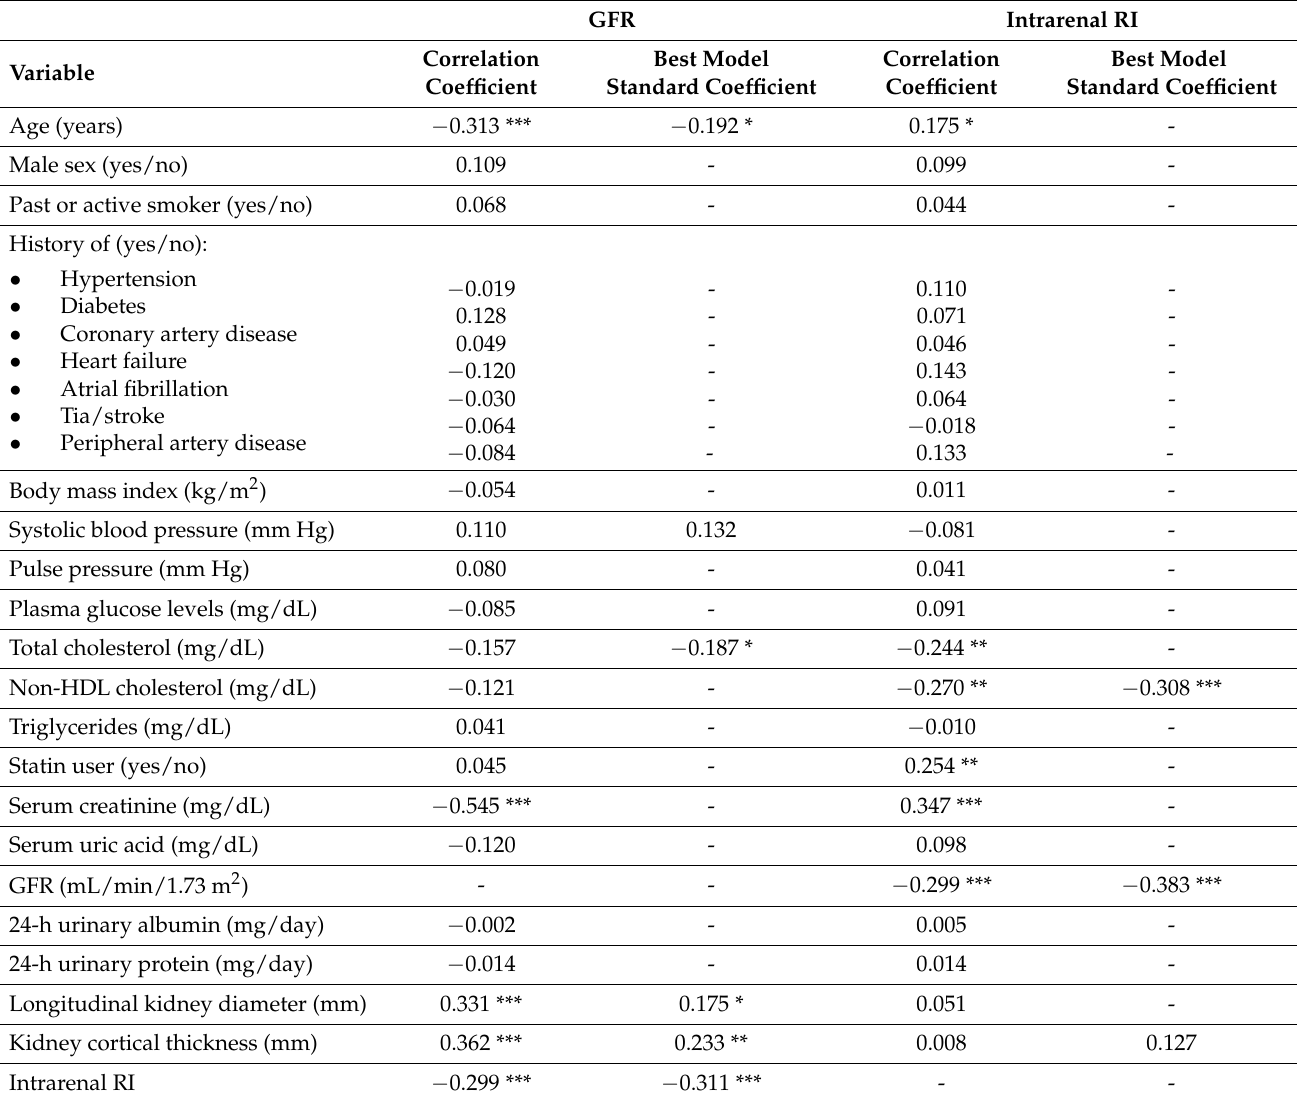
Table 1. Baseline correlation analysis and best model of determinants of GFR and intrarenal resis- tive index.